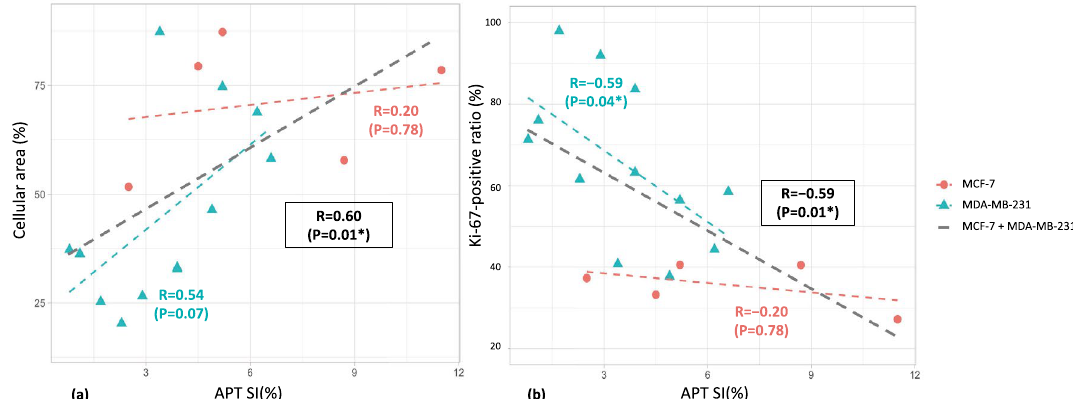
Figure 5. Scatter plots of ( a ) APT SI against cellular area, ( b ) APT SI against Ki-67-positive ratio. The Spearman’s rank correlation coefficients R, the corresponding P values in each tumor are shown in the figure. The black dashed line indicates the relationship between APT SI and histological biomarkers in the entire tumors (mixing MCF-7 and MDA-MB-231 groups).